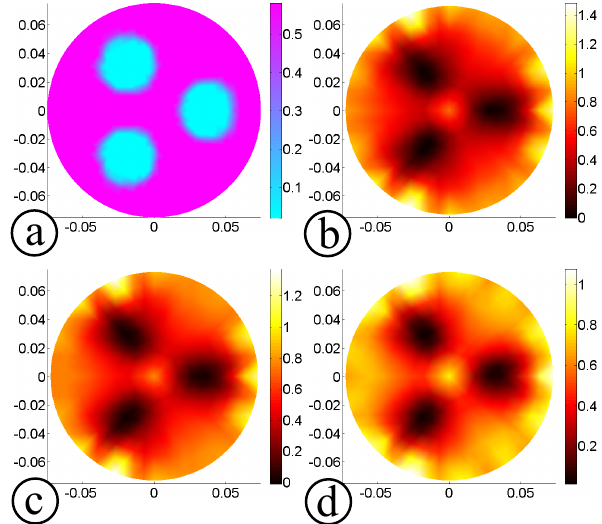
Fi g.18: Conductivity reconstruction of the phantom with tripple inhomogeneity (D = 40 mm, L = 37.5 mm) near electrode No.-1,